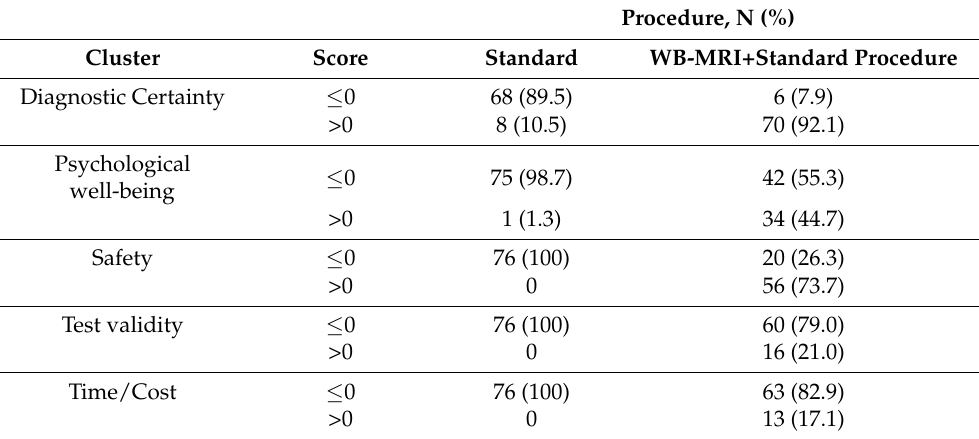
Table 2. Early cancer diagnosis procedure scores expected value † distribution by cluster, N =